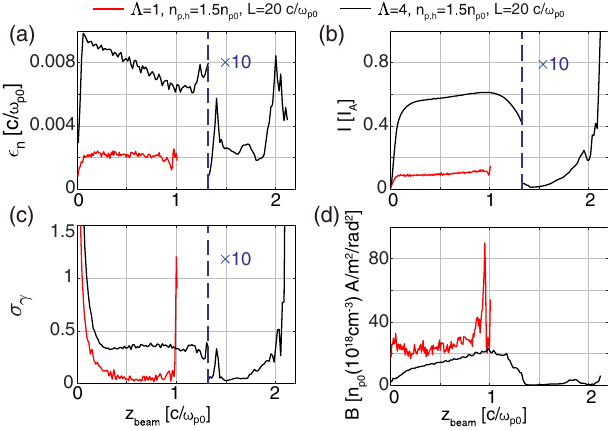
FIG. 4. The parameters of the injected beams in two conditions: (a) the slice emittance, (b) the current, (c) the slice energy spread and (d) the brightness. Here I A ≈ 17 kA is the Alfven current. The beam is divided into 128 slices. The red (black) lines corresponds to Λ ¼ 1 ð 4 Þ . The curves right of the blue dashed lines are attenuated by